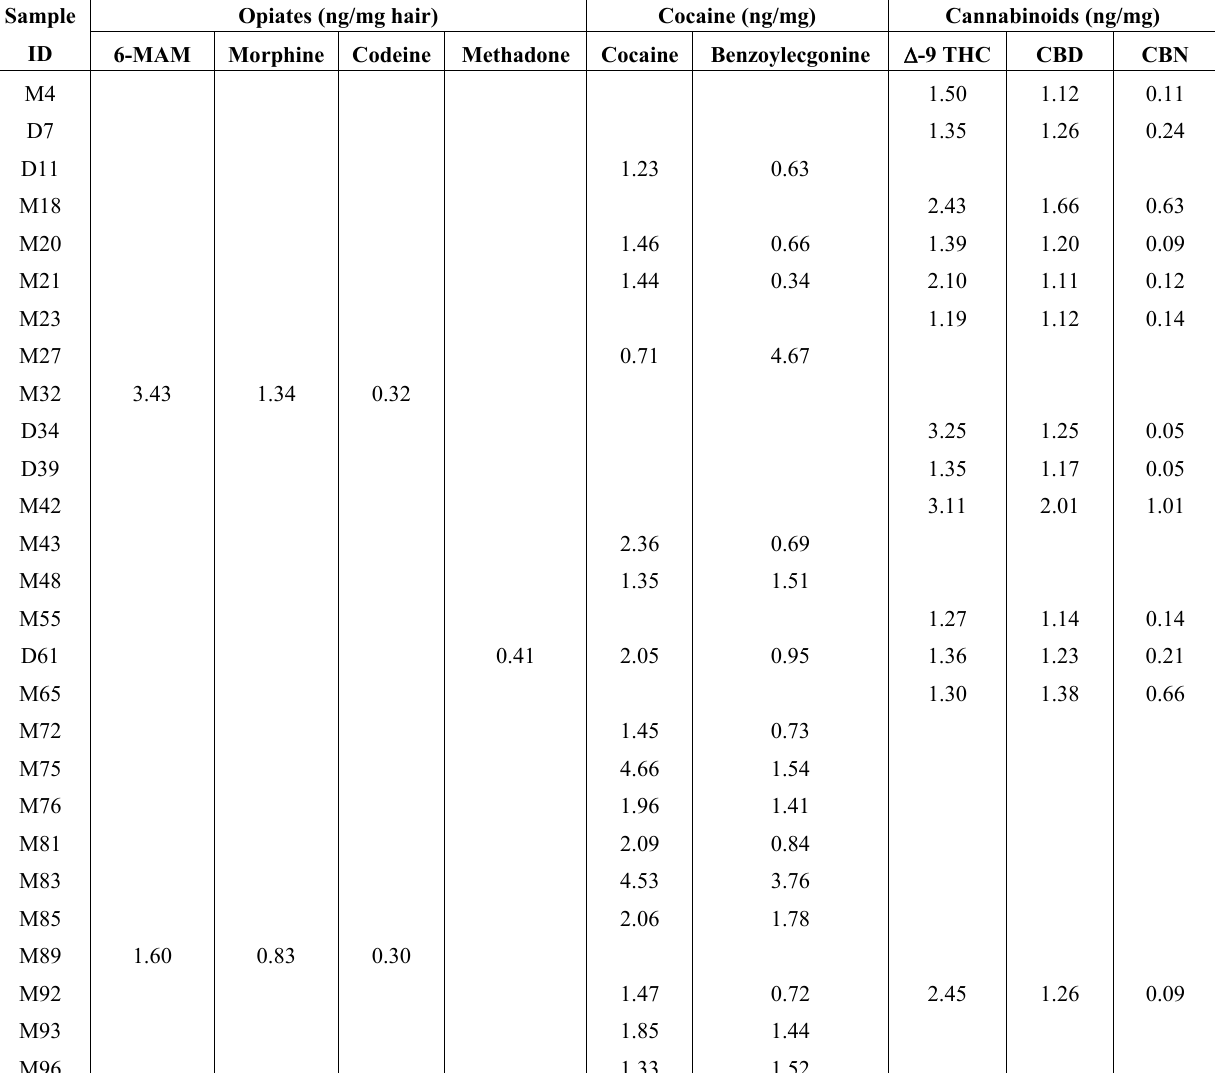
Table 1. Drugs of abuse content in adult hair